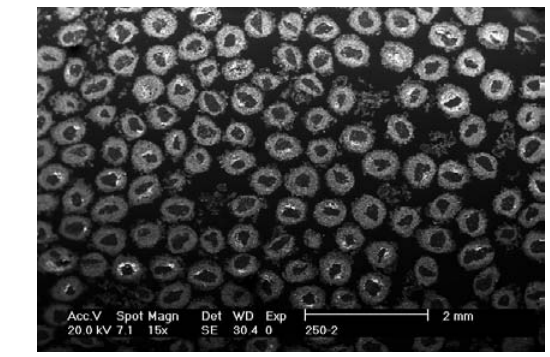
Fig. 1a X-ray micro-tomographic image of Fig. 1b For front cover: the central cross section of a granule. SEM image of internal structure of over 100